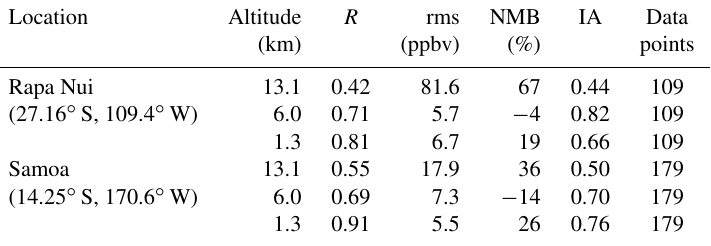
Table 2. Error statistics for model simulation versus observations of monthly averaged O 3 for Rapa Nui and Samoa in the remote Pacific at three altitude levels. We show Pearson correlation ( R ), root mean square (rms – ppbv), normalized mean bias (NMB – %), and index of agreements (IA). The number of data points considered is also indicated. Calculations were made according to Brasseur and Jacob (2017).